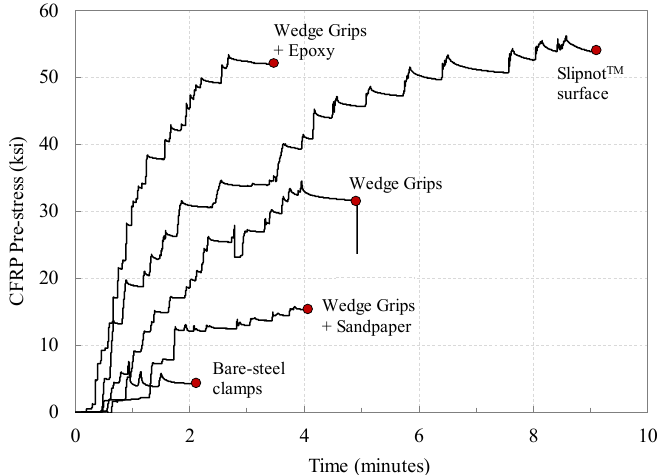
Figure 19. CFRP pre-stress measurements from the different bonding mechanisms considered.